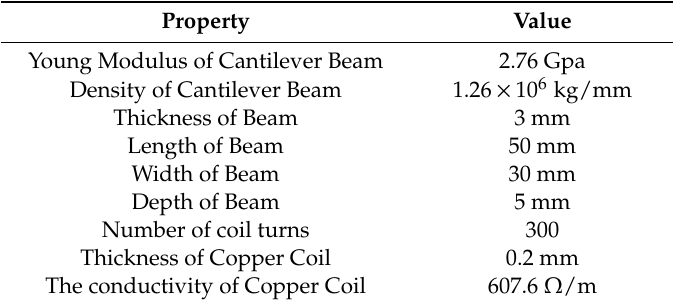
Table 1. Physical and geometrical properties of the beam.